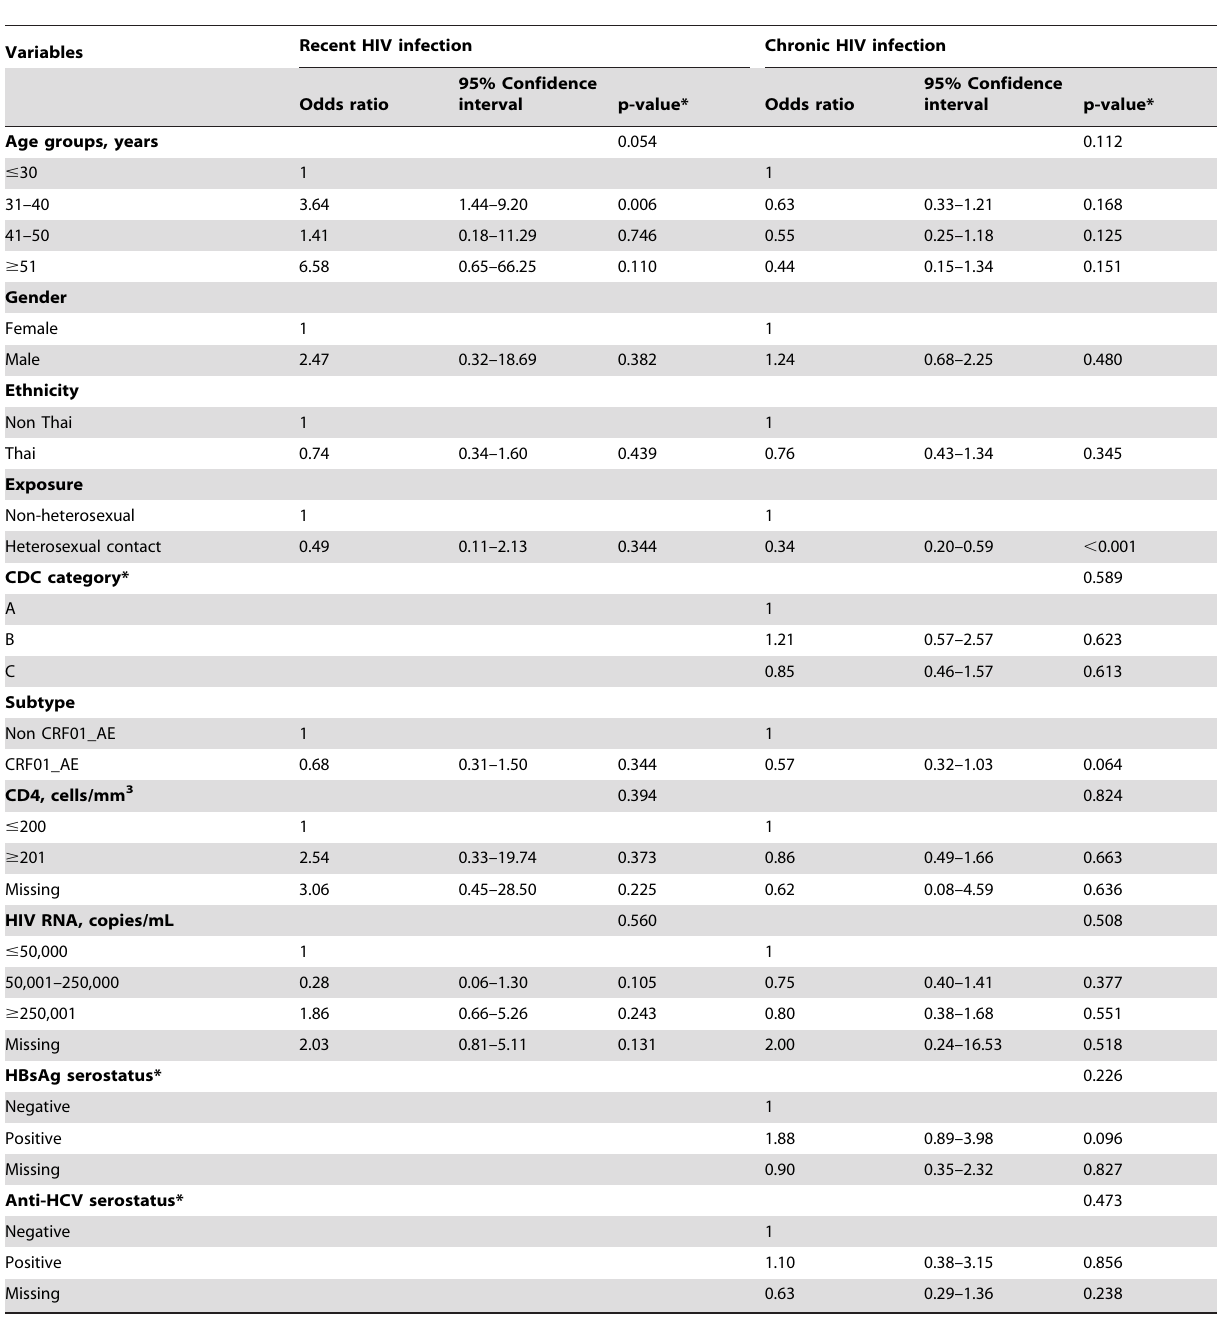
Table 2. Factors associated with primary HIV drug resistance by duration of HIV infection - univariate logistic